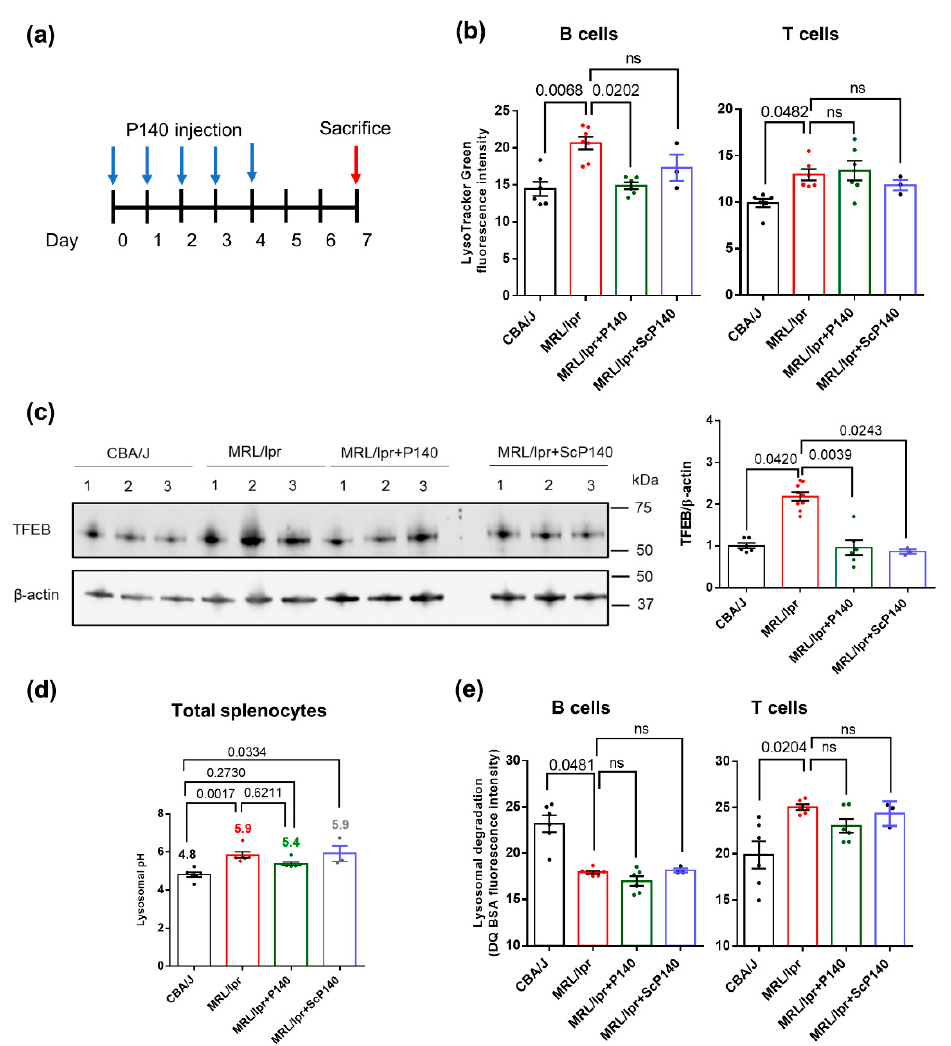
Figure 1. Lysosomal dysfunction in lupus: Total splenocytes were isolated from CBA/J ( n = 6), MRL/lpr mice ( n = 6–9) and MRL/lpr mice that received P140 ( n = 6) or ScP140 ( n = 3) peptides. ( a ) Schematic schedule of injection protocols (5 times of 100 μ g/injection/mice/day for 5 consecutive days; organs taken 3 days after the last injection). Blue arrows indicate the days of injections of P140 or ScP140 peptides and the red arrow indicates the day of sacrifice and collection of organs. ( b ) LysoTracker Green mean fluorescence intensity of CD19 + /CD3 − B cells and CD19 − /CD3 + T cells from the four study groups of mice as assessed by flow cytometry. ( c ) Expression levels of Transcription factor EB (TFEB) in purified B cells from the four study groups as examined by Western blotting. ( d ) Mean lysosomal pH values splenocytes of the four study groups of mice as measured using LysoSensor Yellow/Blue DND-160. The pH value was calculated using a standard curve shown in Supplementary Figure S1. ( e ) Measurement of proteolytic capacities of lysosomes from CD19 + /CD3 − B cells and CD19 − /CD3 + T cells of the four study groups of mice, as evaluated by flow cytometry in measuring Self-Quenched BODIPY Dye Conjugates of Bovine Serum Albumin (DQ-BSA)fluorescence intensity. In ( b , d , e ), each point represents the mean value of the experimental triplicates. In (c) each point represents one mouse, in total 7 CBA/J mice, 9 MRL/lpr mice, 6 MRL/lpr mice + P140 and 3 MRL/lpr mice + ScP140. One-way ANOVA Krustal-Wallis test was used to analyze the statistical significance. Error bars are ± SEM. ns means p values > 0.05.